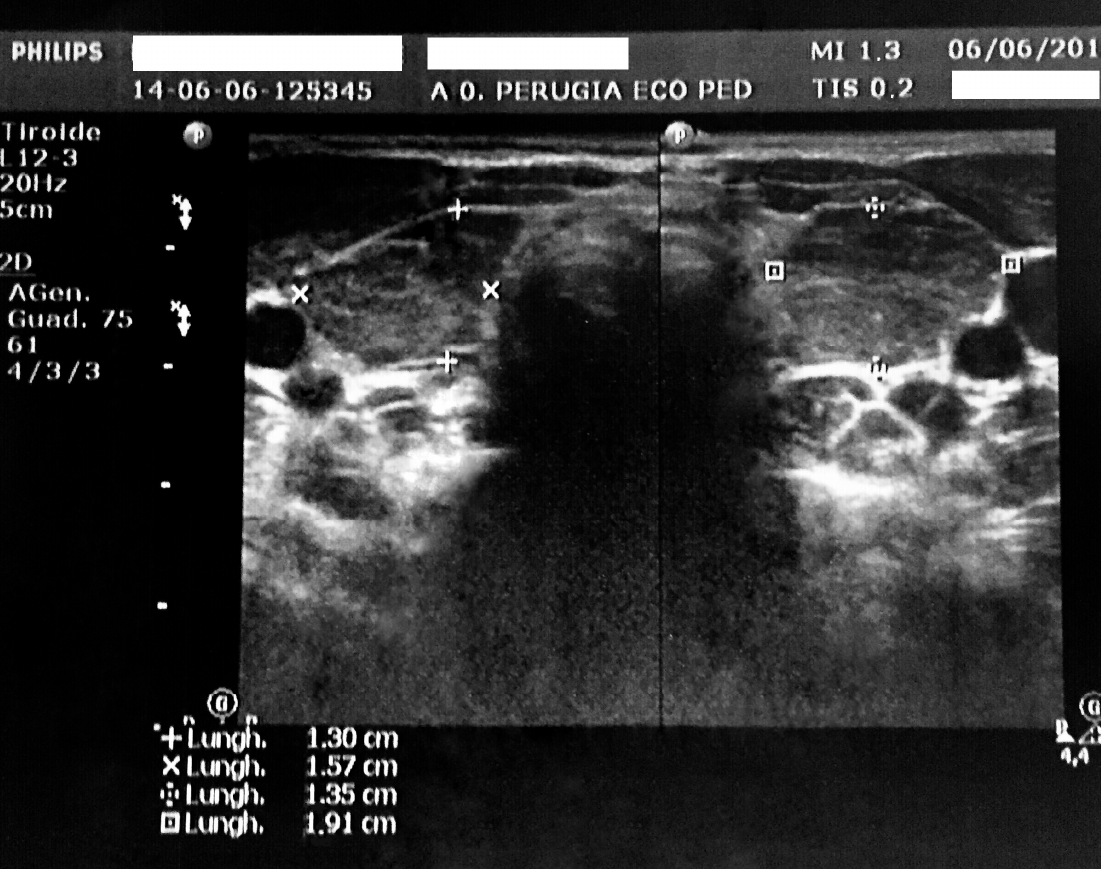
Figure 2. Thyroid ultrasound with evidence of increased gland dimensions and a non-homogeneous echotexture aspect.